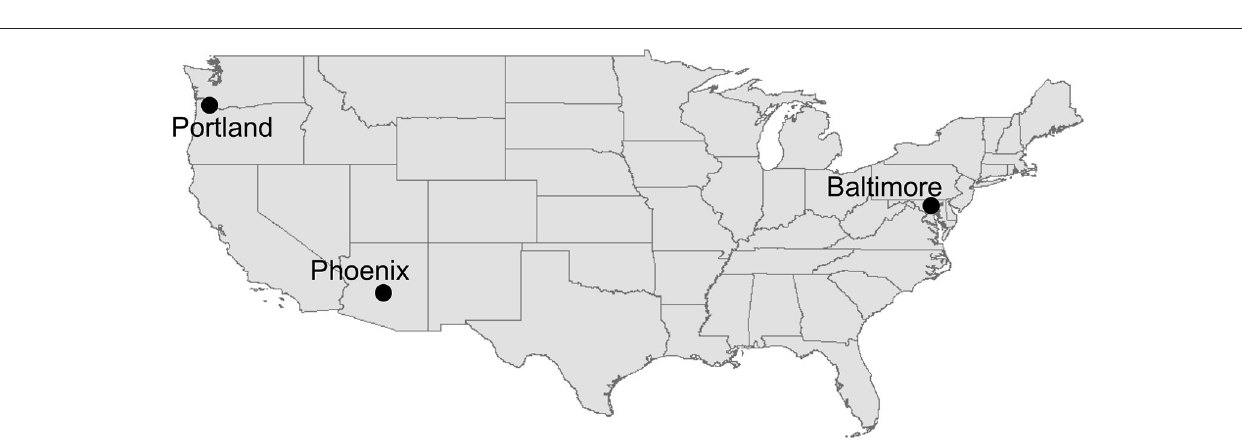
FIGURE 2 | Map of study